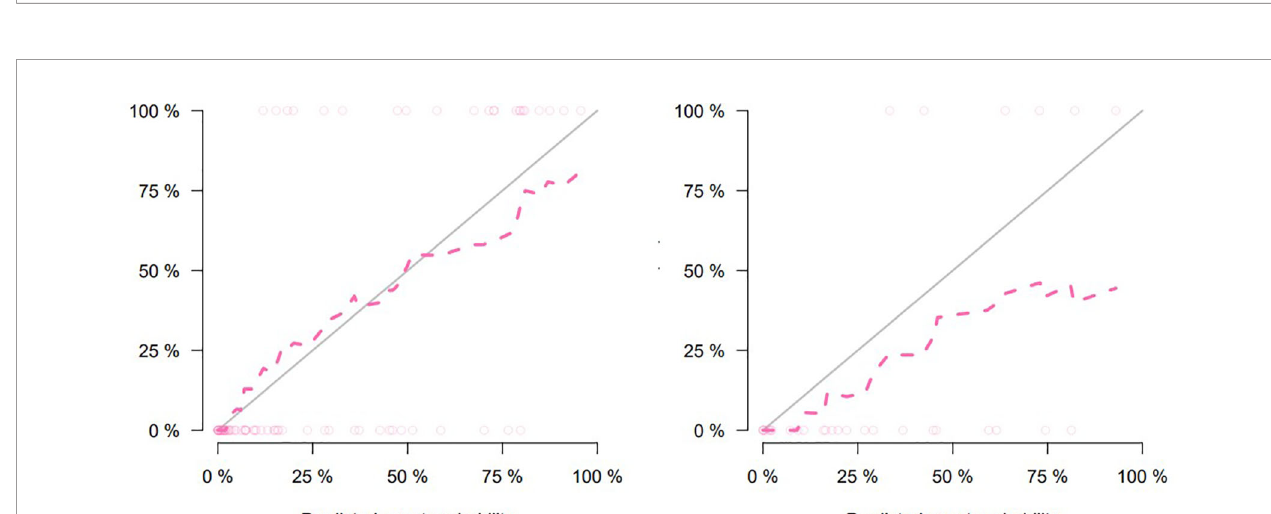
FIGURE 4 | Clinical –